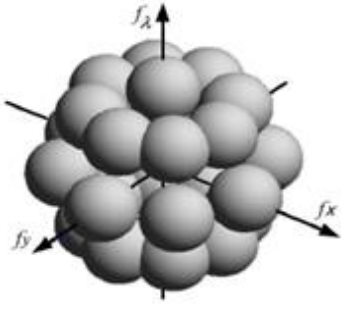
Figure 2. 3D Gabor